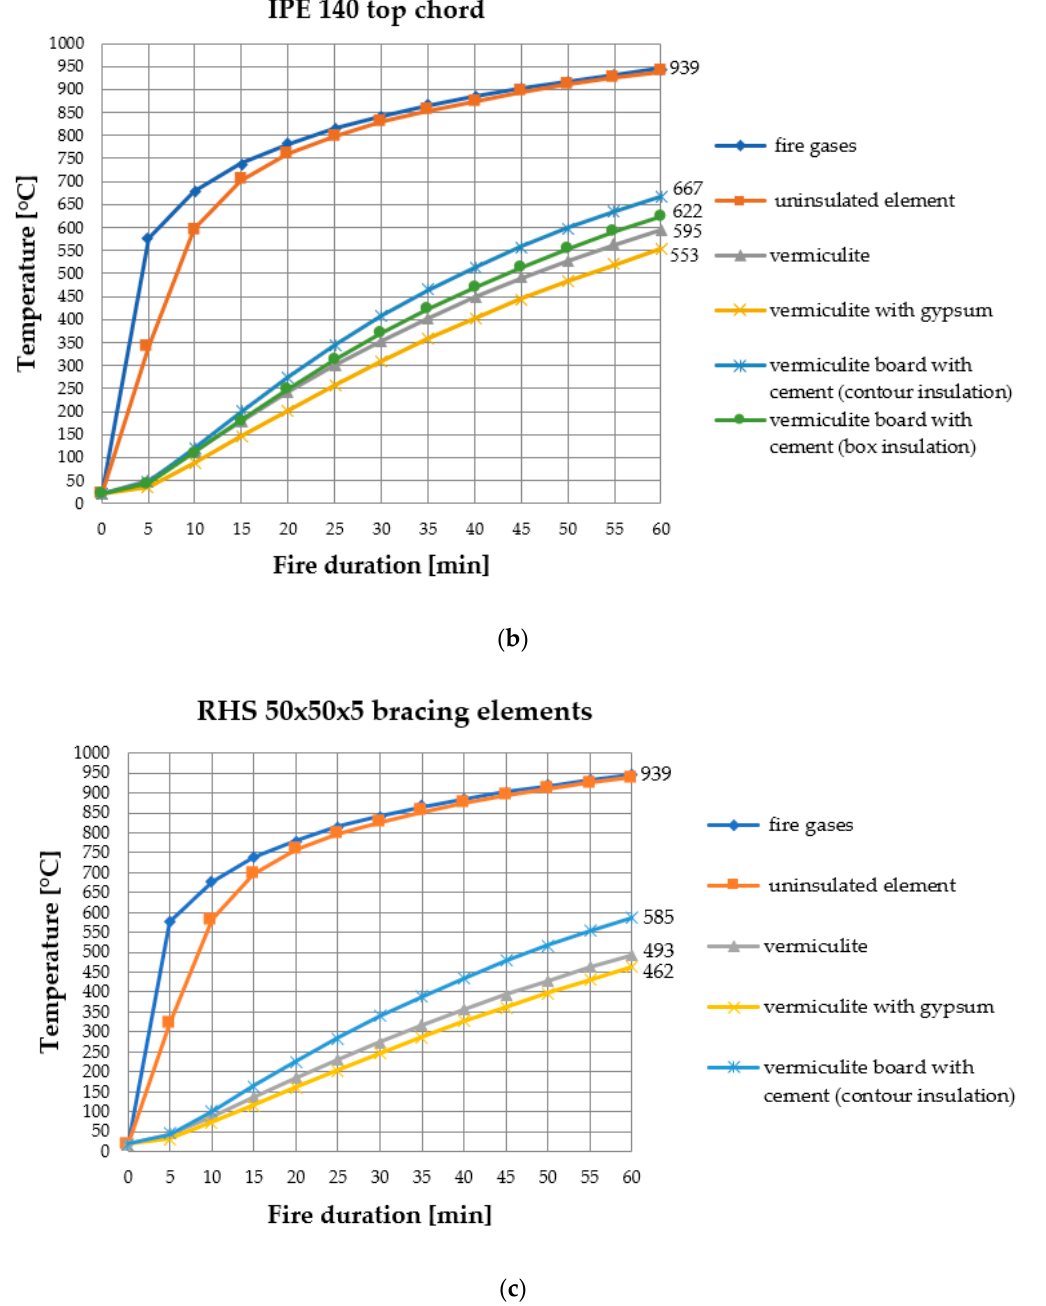
Figure 3. Temperature of steel members in the successive minutes of the fire (insulation 2 cm): 333 ( a ) I 100 bottom chord, ( b ) IPE 140 top chord, ( c ) RHS 50x50x5 bracing elements. 334